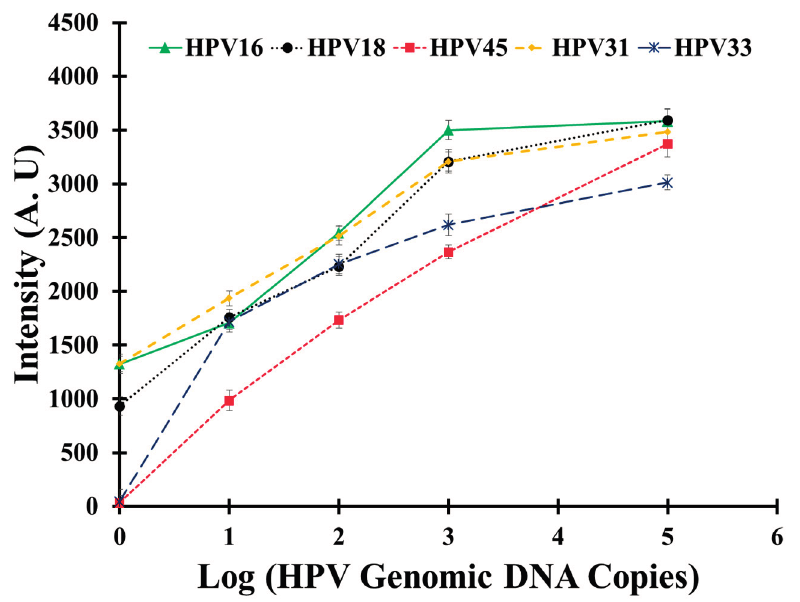
Figure 4. Standard curve of the fluorescent intensity corresponding to the number of copies of HPV DNA detected by using the HPV 9G membrane